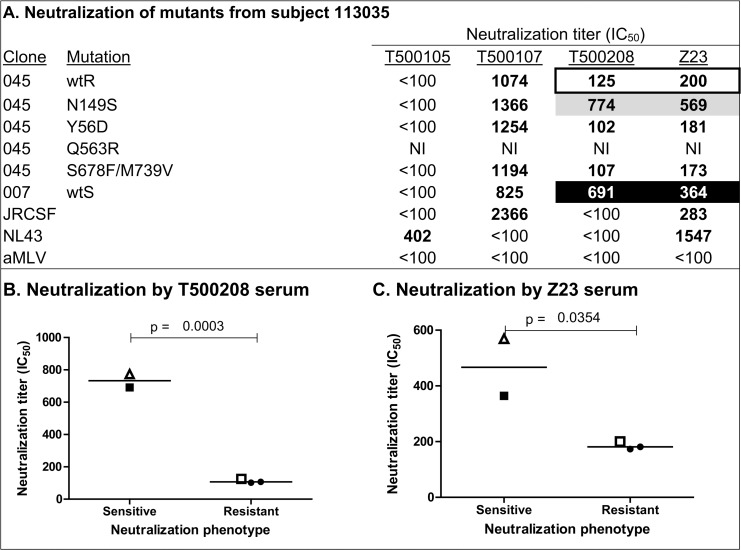
Mutational analysis to map residues responsible for differences in neutralization sensitivity and resistance in Envs from subject 113035.Amino acids from the neutralization-sensitive clone (007) were systematically inserted into the neutralization-resistant Env (045). (A) Effect of amino acid polymorphisms on neutralization by plasma from four HIV-1 infected subjects. The neutralizing antibody titer (IC50) is defined as the reciprocal of the plasma dilution that produces a 50% inhibition in target cell infection. Values in bold represent significant neutralization titers that are at least three times greater than those observed against the negative control (aMLV). Panel A, open rectangle, indicates neutralization titers for the wildtype resistant (wtR) clone; black rectangle, indicates neutralization titers for the wildtype sensitive (wtS) clone; gray rectangle, indicates the single amino acid substitution that converted the neutralization-resistant Env into a neutralization-sensitive Env. NI, indicates a non-infectious mutant. Panels B and C represent graphs and statistical analysis of neutralization of 113035 mutants with the T500208 and Z23 plasma, respectively. Panels B and C, closed square (■) indicates neutralization titers of wtS clone 007; open square (□) indicates neutralization titer of wtR clone 045. Open triangles (△) indicate neutralization titers of wtR clone 045 incorporating the N150S mutation. Closed circles (●) indicate neutralization by the other mutants listed in panel A. Statistical significance was calculated using an unpaired t test.